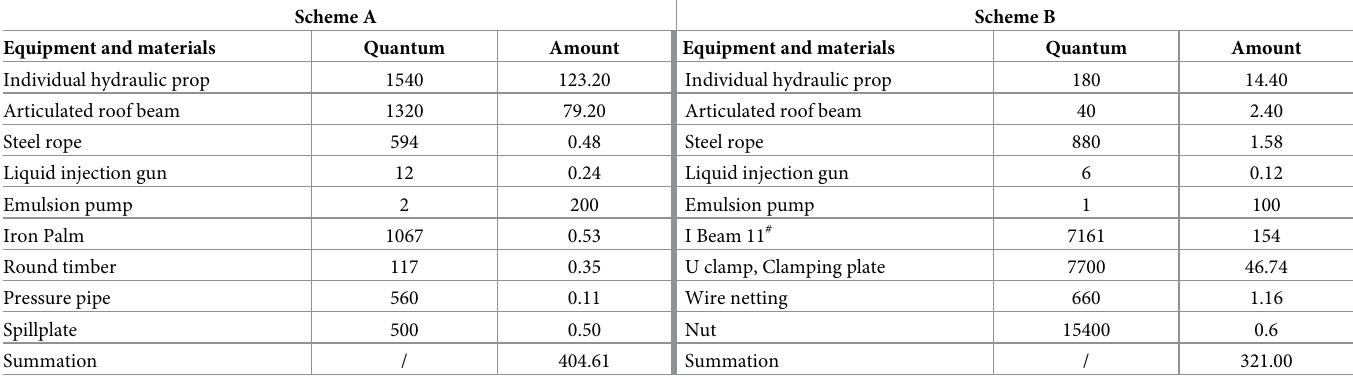
Table 4. Equipment and materials in the working